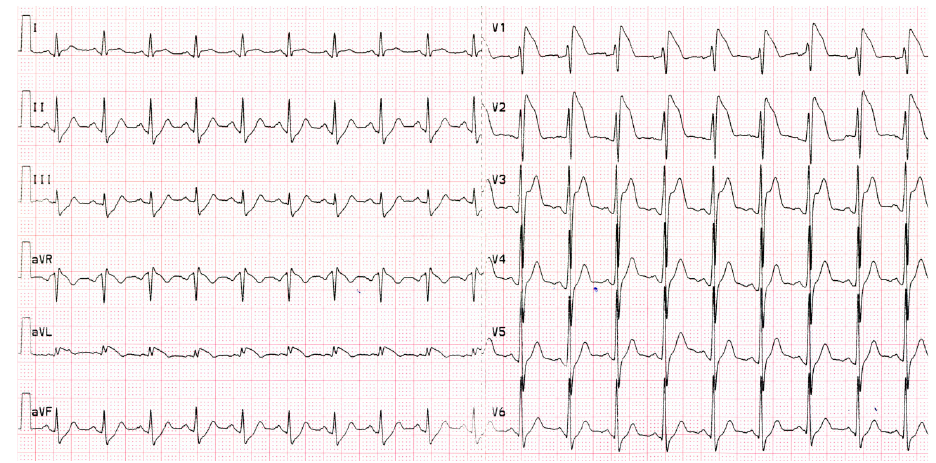
Fig. 2. Brugada syndrome (published with the permission of ass.professor Čestmír